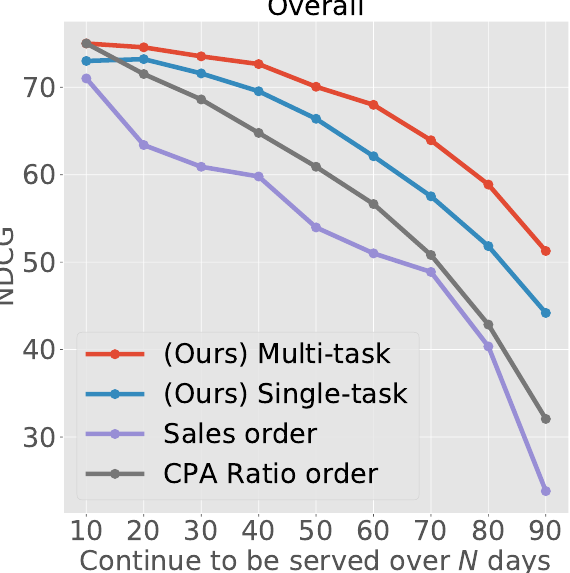
Figure 4. Comparison of the NDCG for the following prediction and actual discontinuation orders for each continuous serving days: by our framework (i.e., single-task and multi-task) and by the rule-based on the sales and the CPA